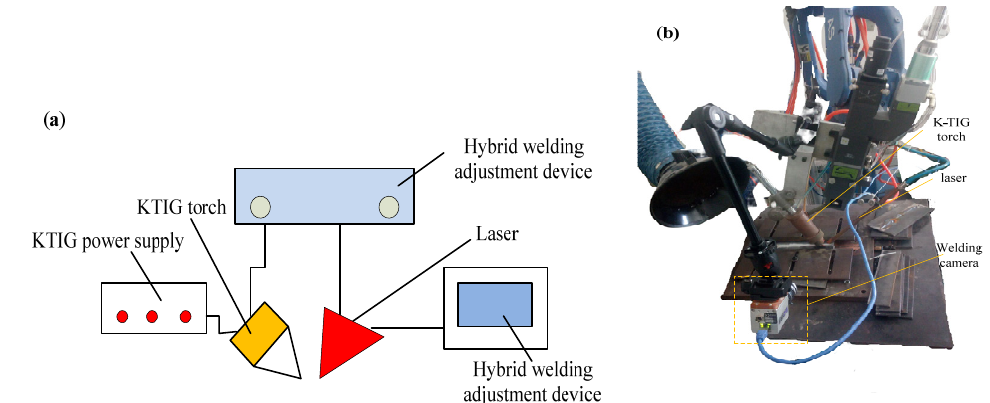
Figure 1. Laser K-TIG hybrid welding system: ( a ) schematic diagram, ( b ) structural hybrid diagram.